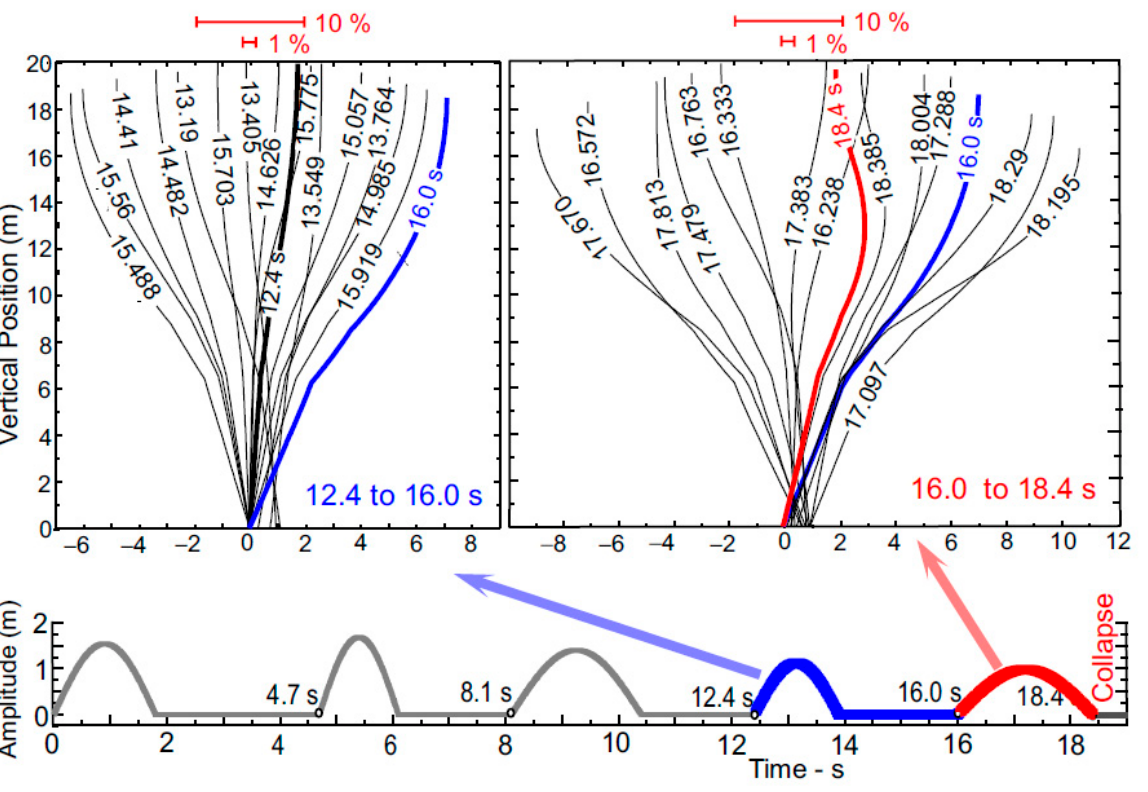
Figure 15. Model displacements during the last two pulses. The roof displacements corresponding to 1% and 10% drifts are shown in red lines above the figure. Consecutive displacements of the building are shown during the last two pulses. The duration times corresponding to the plotted configuration are shown in seconds.